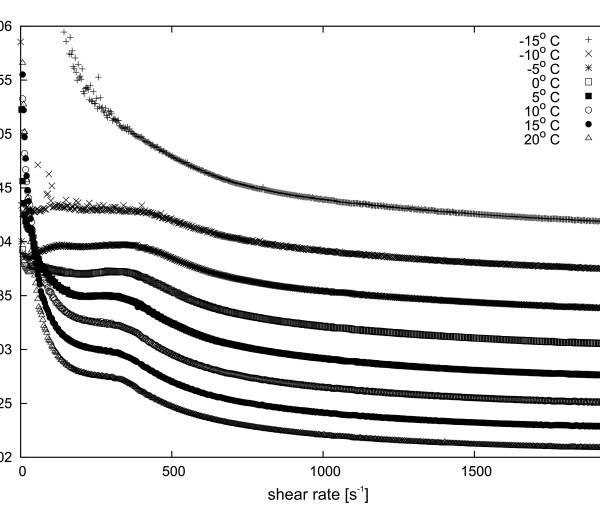
Dynamic viscosity dependence of 15 wt. % Y3Al5O12nanopowder suspension in ethyl alcohol at various temperatures.